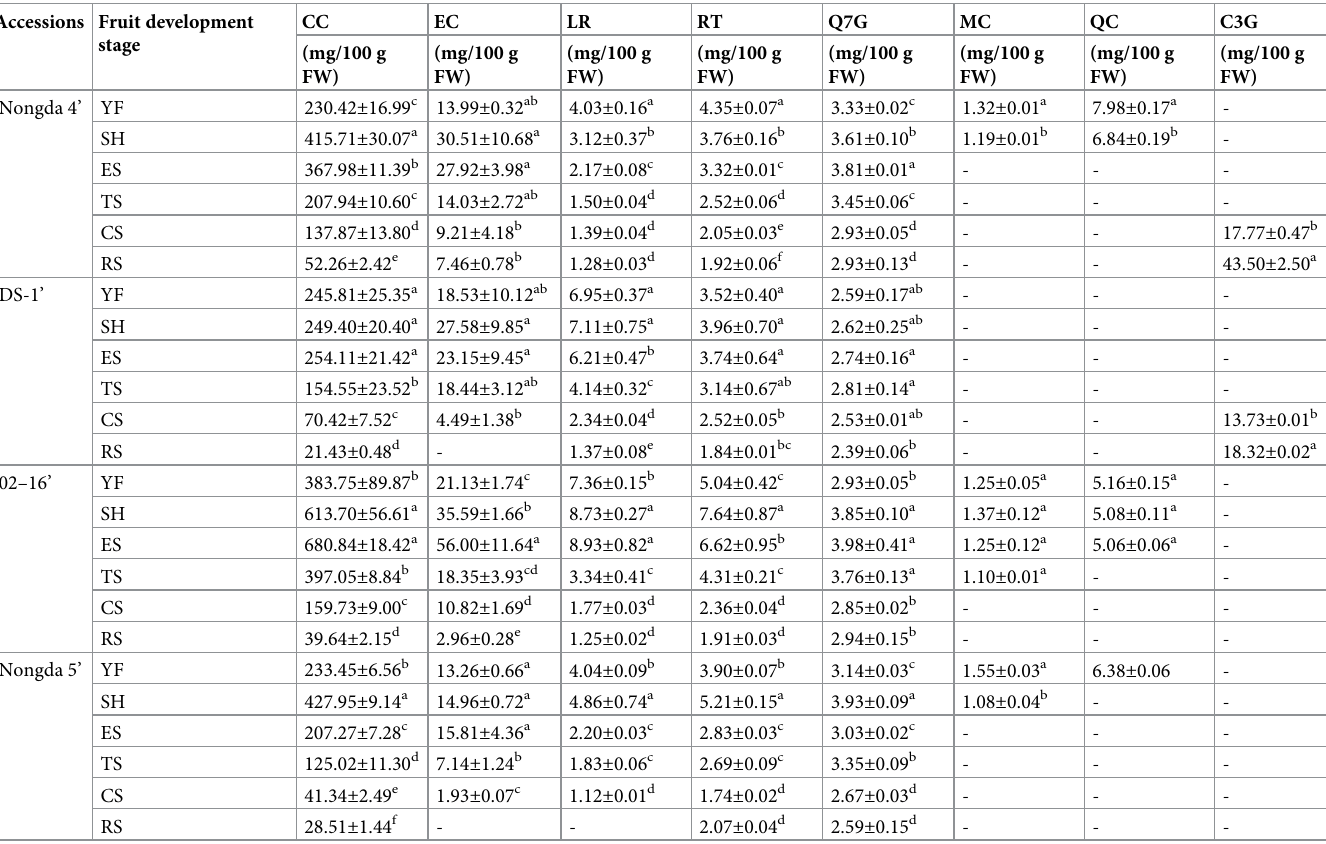
Table 2. Dynamic change of flavonoid components in Prunus humilis fruits. Accessions Fruit development